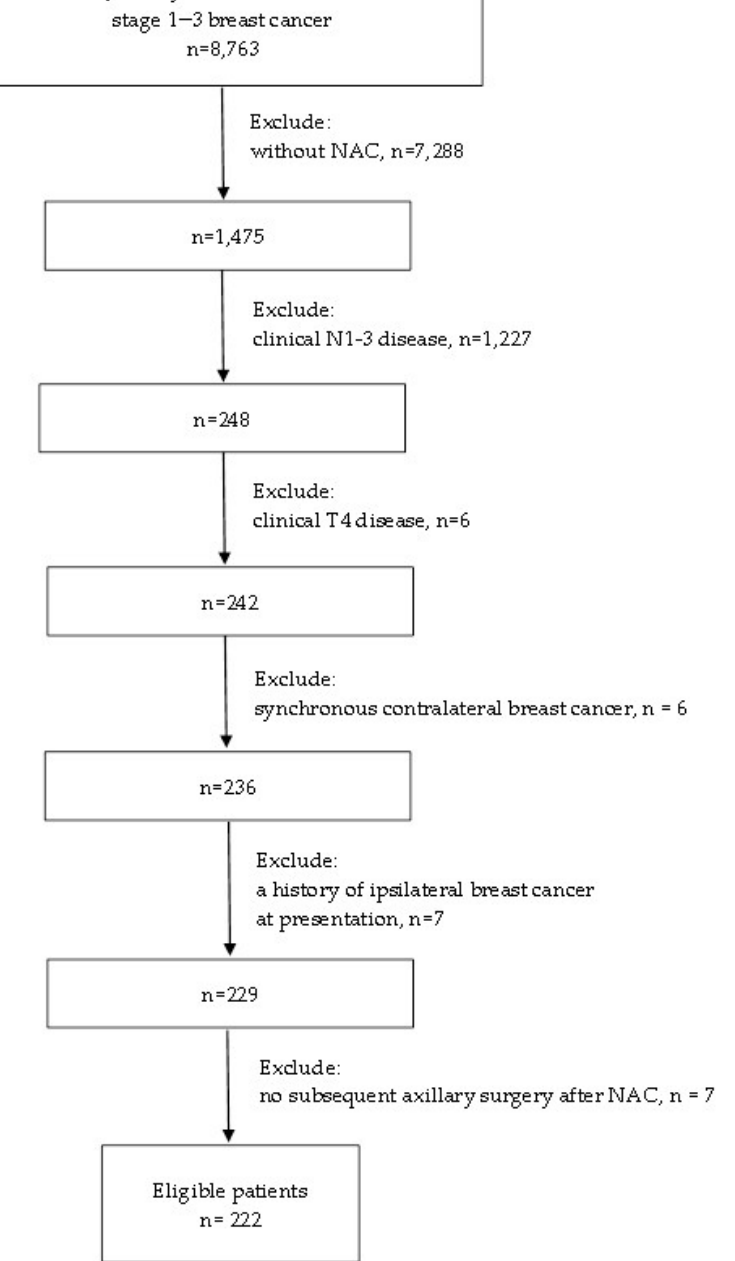
Figure 1. The flow diagram of the study. NAC, neoadjuvant Figure 1 . The flow diagram of the study. NAC, neoadjuvant chemotherapy.